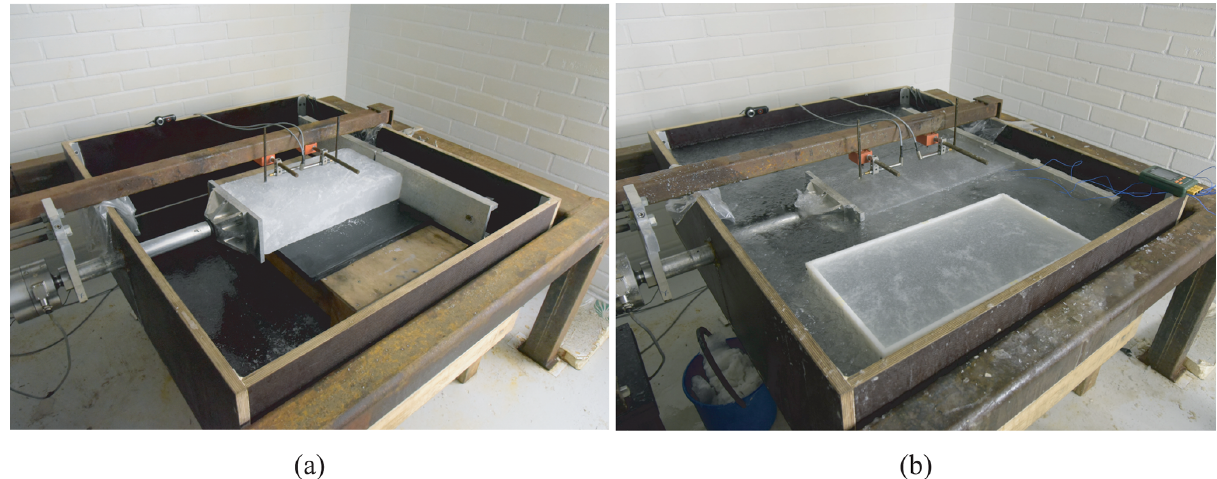
Figure 2. Equipment used in the (a) dry and (b) floating-ice experiments. One of the plastic molds used when growing ice is shown in (b) . The thin ice cover of the basin, seen in (b) , was broken before performing the